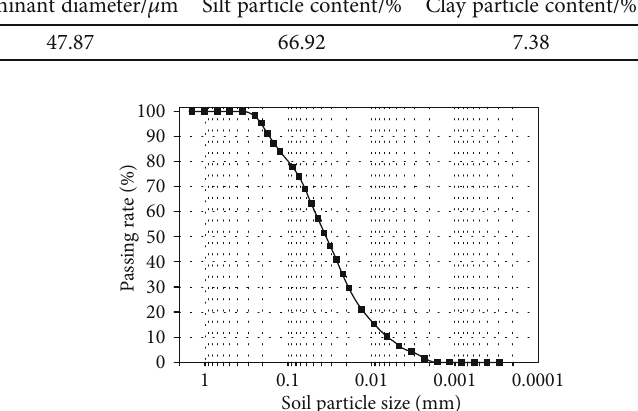
Table 1: Physical parameters of used clay soil sample. Plastic limit, ω p Liquid limit, ω L